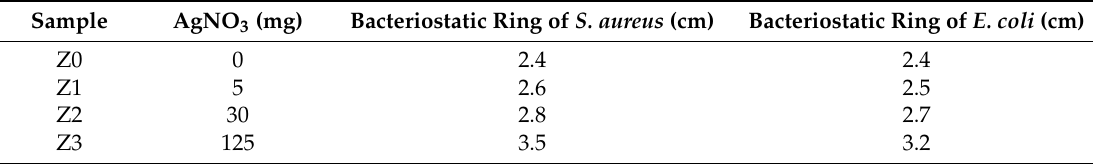
Table 1. The diameter of the bacteriostasis circle of the